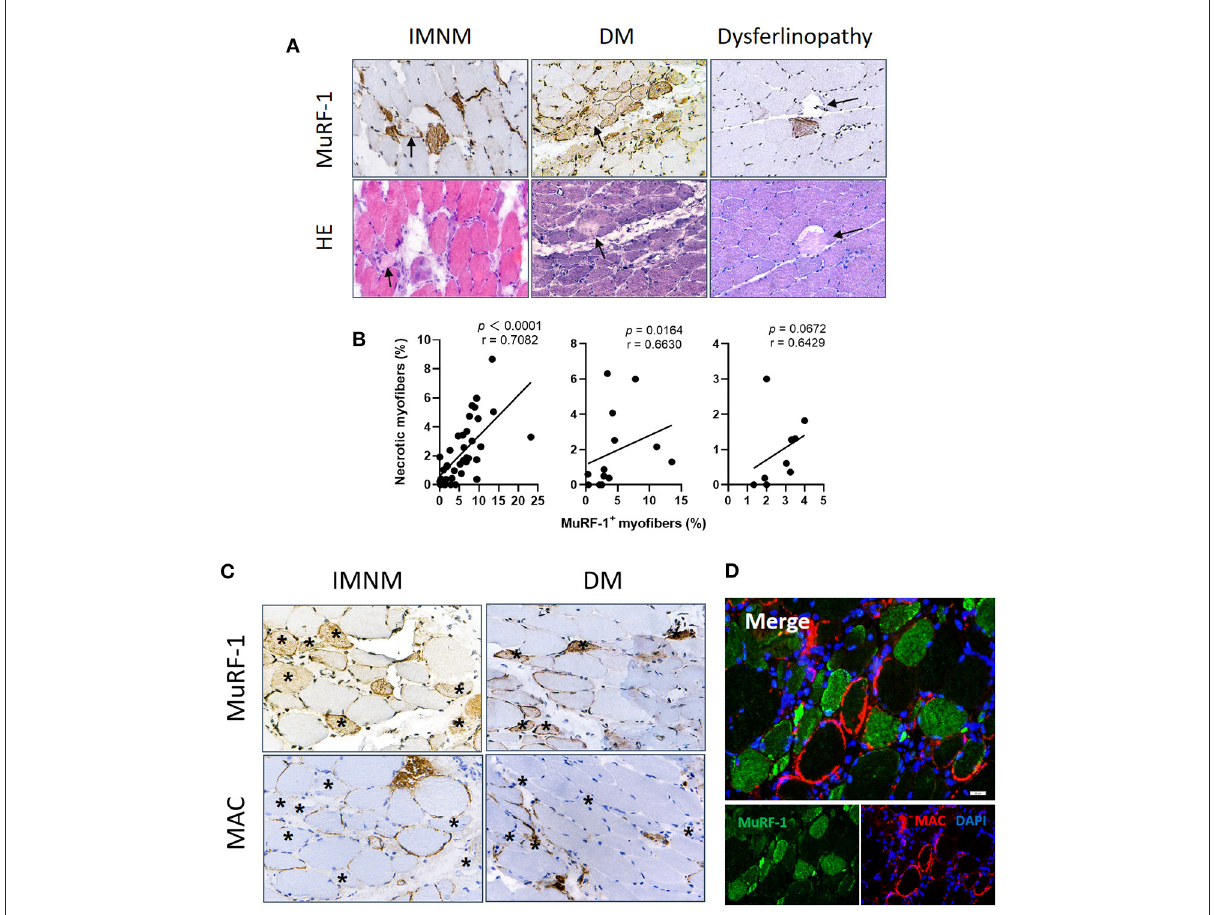
FIGURE4 Muscle RING finger-1 (MuRF-1) staining were distributed around damaged myofibers. (A) Necrotic myofibers were negative for MuRF-1 in IMNM, DM and dysferlinopathy biopsies, whereas they were surround by MuRF-1-positive fibers (black arrows: necrotic fibers). Magnification: × 400. (B) Correlations between the percentage of MuRF-1 positive fibers and myonecrosis in IMNM, DM and LGMD. (C) Most myofibers with MAC staining were negative for MuRF-1 in IMNM and DM biopsies (examples *). Magnification: × 400. (D) Double immunofluorescence